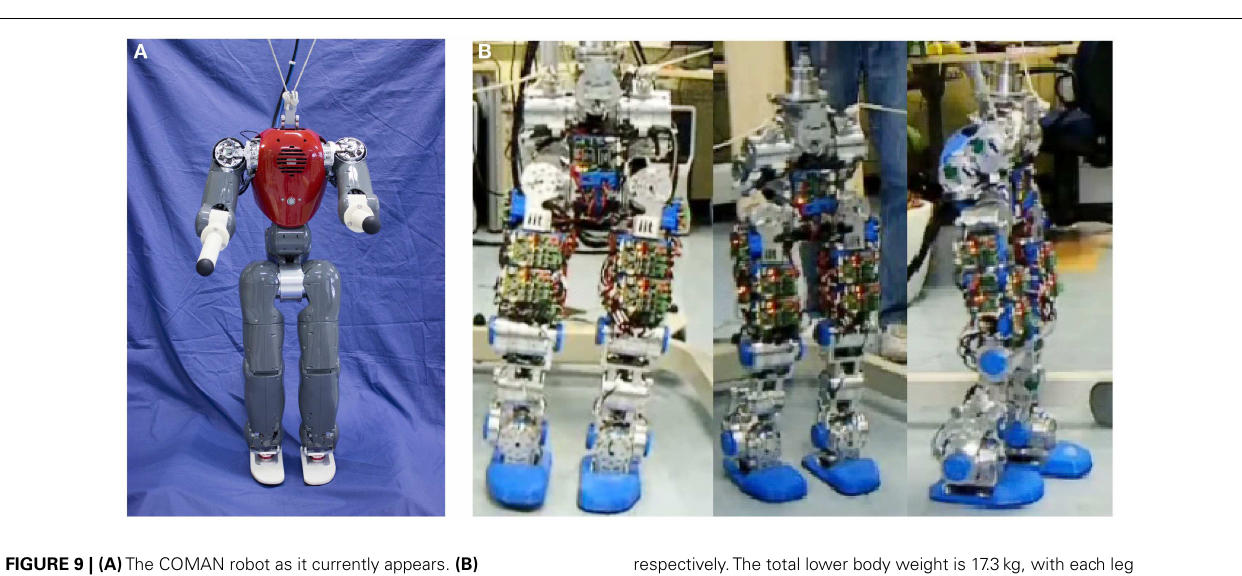
FIGURE 9 | (A) The COMAN robot as it currently appears. (B) Snapshots from the video of the COMAN robot walking human-like, with CoM trajectory reconstruction from kMPs.The height of the COMAN lower body, from the foot to the waist, is 671mm, with a maximum width and depth (at the hips) of 176 and 110mm,